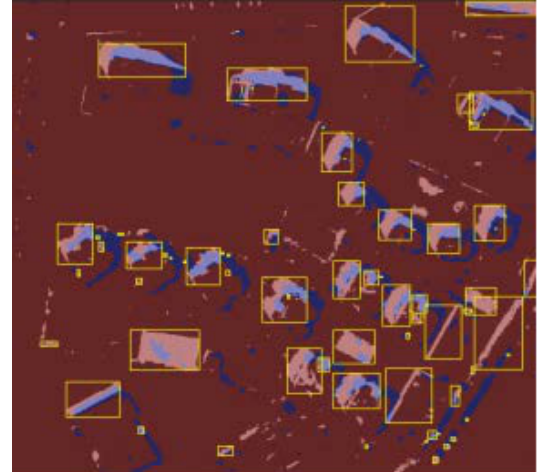
Figure 5. Mean-shift segmentation